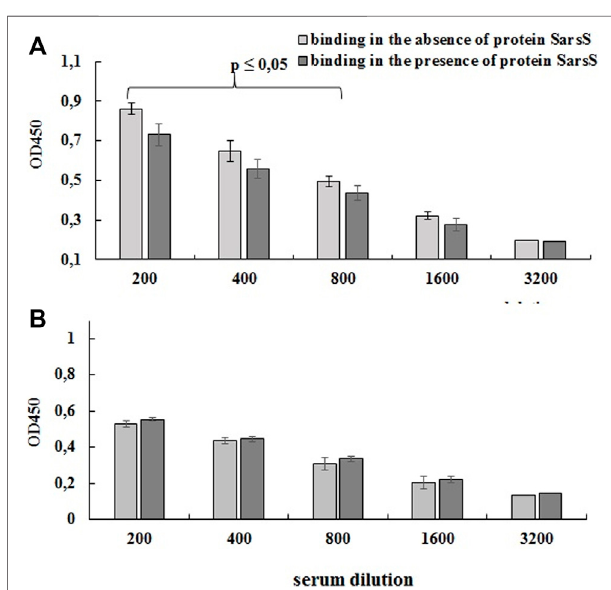
FIGURE6| DetectionofproteinSarsSonthesurface ofE.faecium L3by ELISA. A serum of patients recovered from SARS-CoV-2 was analyzed by competitive ELISA in the 96-well plates covered with L3-SARS (A) and E. faecium L3 (B) . The results allowed evaluating the effect of SARS-Cov-2 speci fi c serum to bind modi fi ed Enterococcus strain after the preliminary incubation with recombinant SarsS protein. The fi gure shows the data of one ofthethree independent experiments, theconclusionsfrom whichcompletely coincided.Eachpointistheaverageoffourmeasurements.Datapresentedas mean ± SEM. Data were analyzed using the Student ’ s